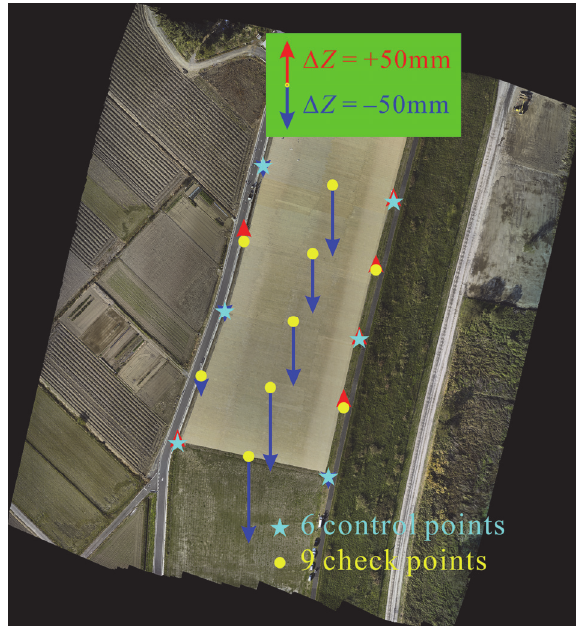
Figure 15. Vertical errors in Flight number 4 by Phantom 4